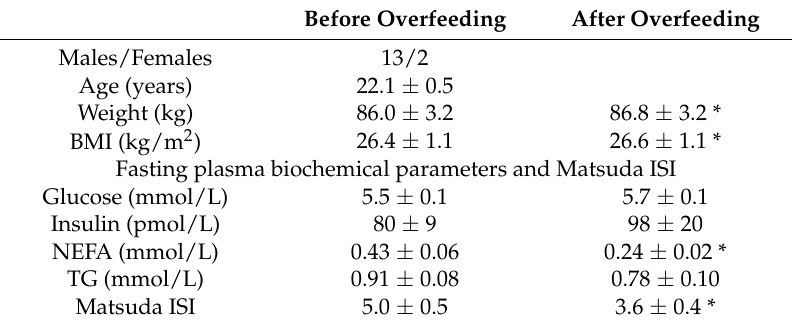
Table 2. Subject characteristics before and after one day of high-fat overfeeding.